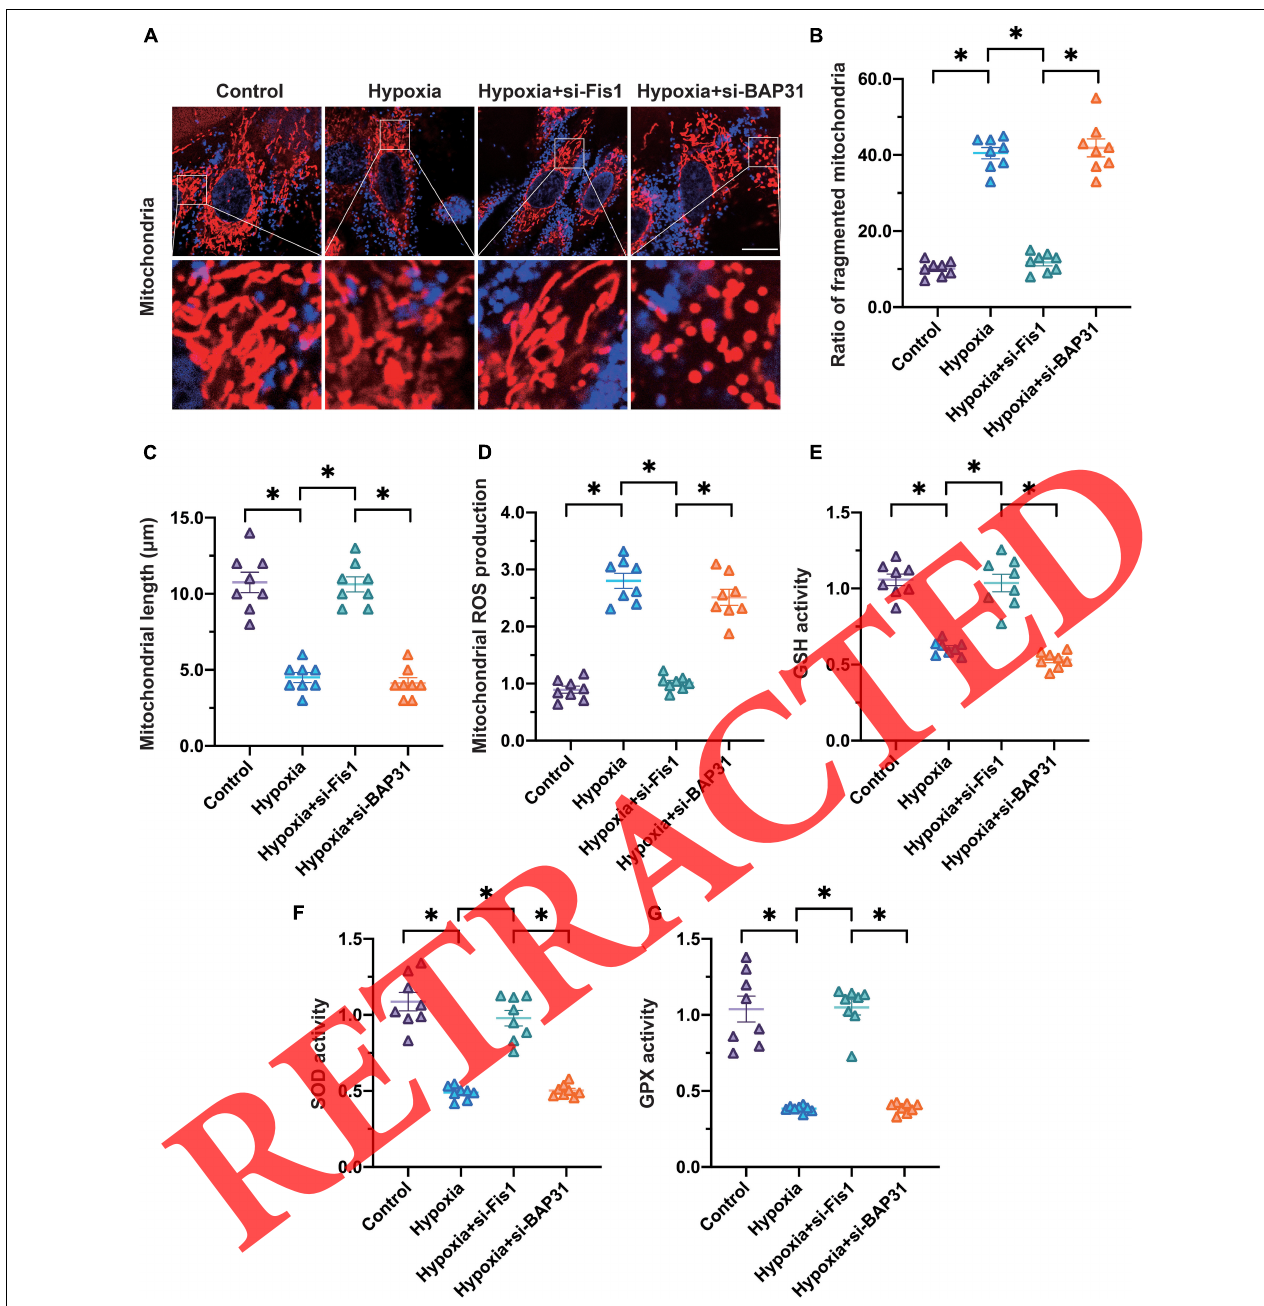
FIGURE 4 | Silencing of Fis1 or BAP31 attenuates mitochondrial division and oxidative stress. (A–C) Cardiomyocytes were subjected to hypoxia to mimic myocardial infarction in vitro . SiRNAs were used to attenuate Fis1 or BAP31 expression in cardiomyocytes. Then, an immunofluorescence assay was used to detect the mitochondrial morphology. The average length of the mitochondria and the percentage of fragmented mitochondria were recorded. (D,E) MtROS were detected using an immunofluorescence assay. (F,G) ELISAs were used to analyze anti-oxidative enzyme activity. * p <